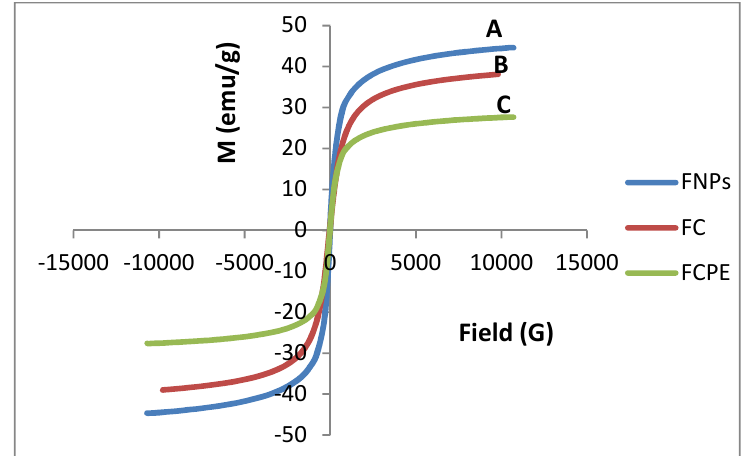
Figure 3. Magnetization curves of ( A ) iron oxide magnetic nanoparticles (FNPs), ( B ) iron oxide coated with chitosan (FC) and ( C ) iron oxide nanoparticles coated with chitosan-prindopril erbumine (FCPE).